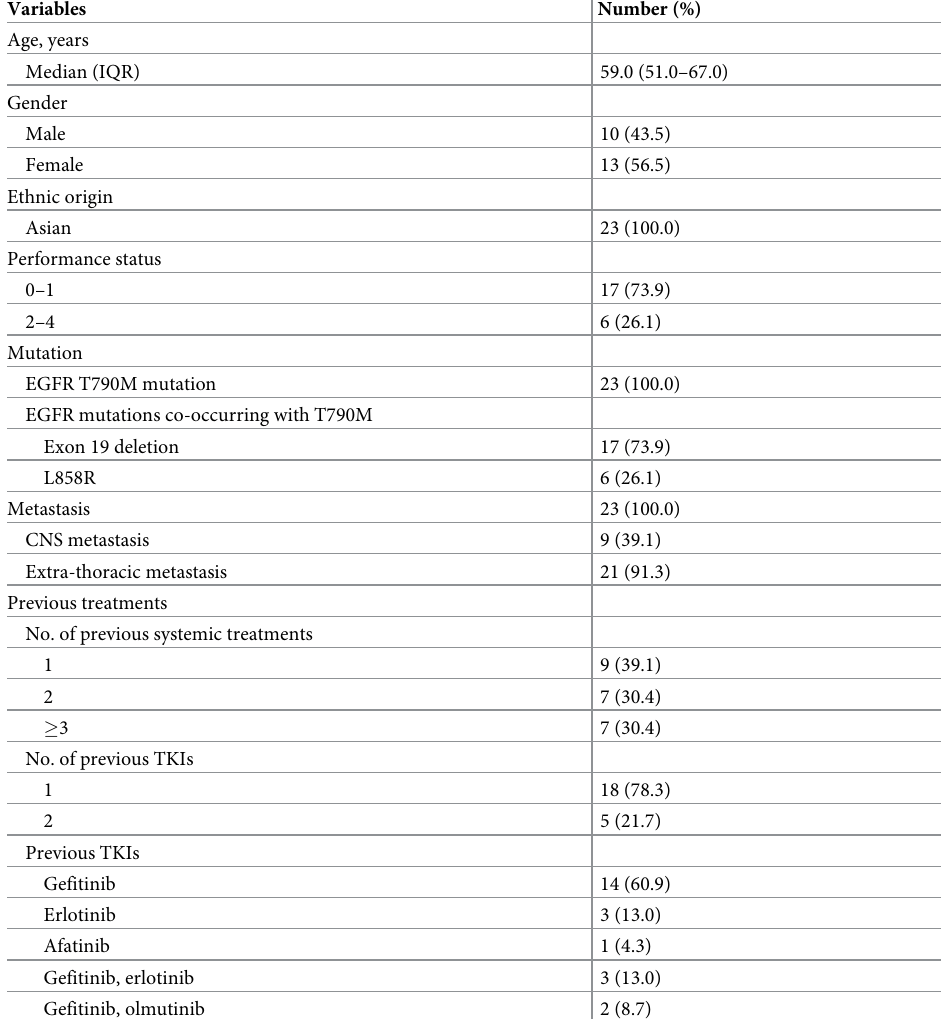
Table 1. Baseline characteristics of the included patients (n =